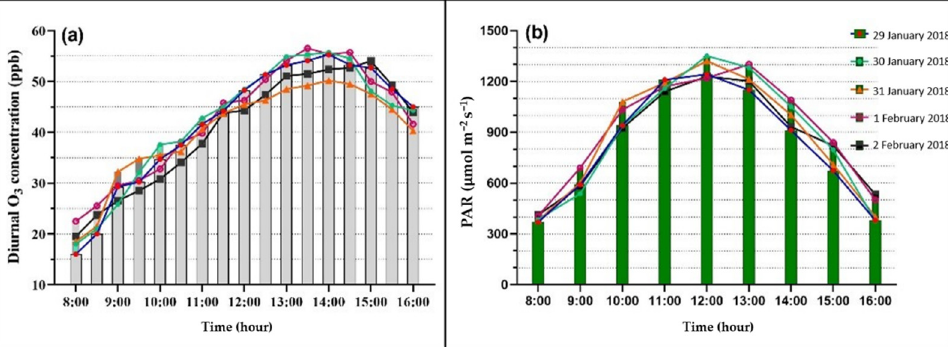
Figure 1. The profile of ambient O 3 concentration ( a ) and ambient PAR ( b ) at the experimental site from 29 January 2018 to 2 February 2018.